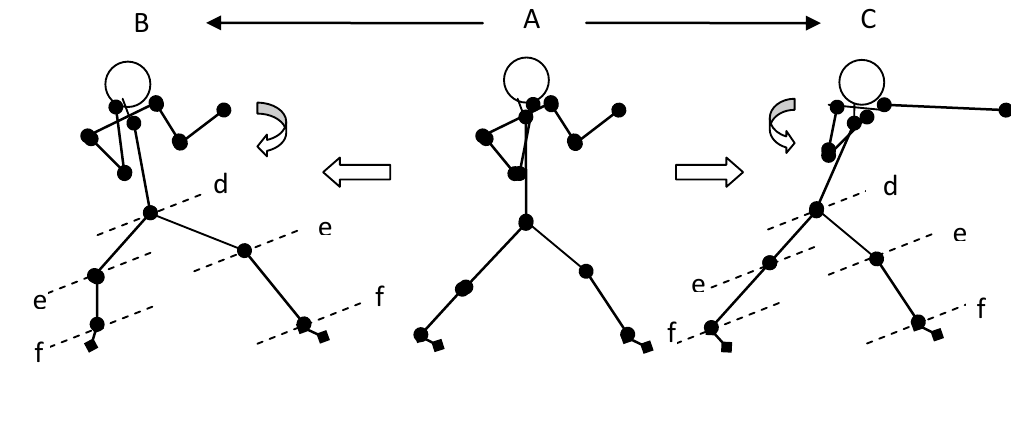
Fig. 1. Diagram of motion (shifting of weight) of body with swaying away and counter attak of straight punch standing in